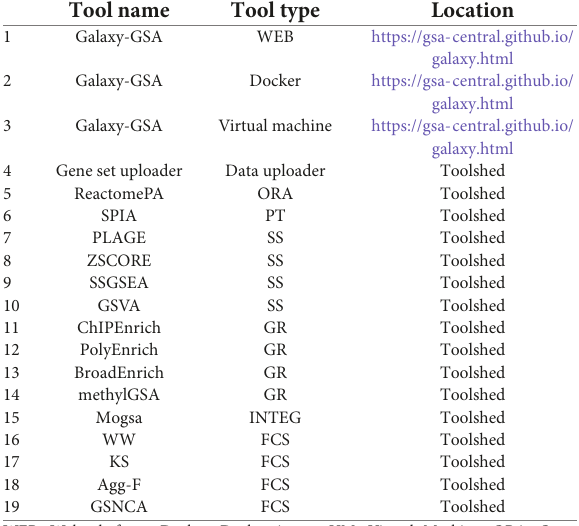
TABLE 1 A list of current servers and individual tools for